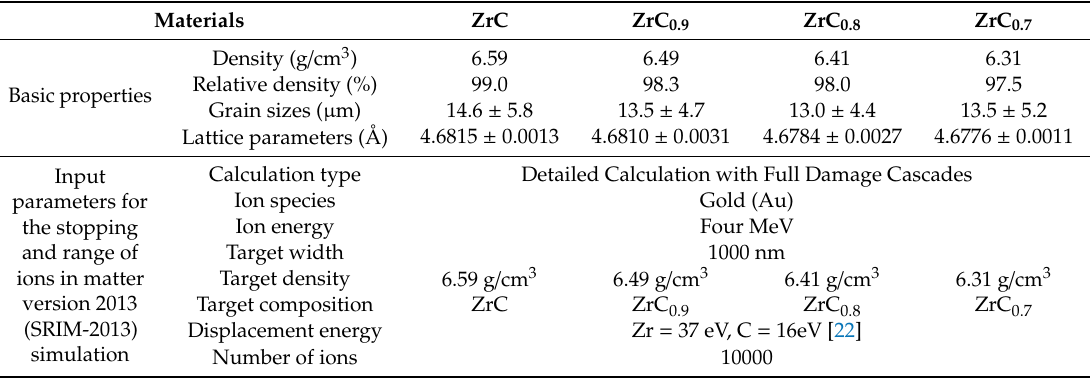
Table 1. Basic properties of ZrC x with four stoichiometries and input parameters for SRIM